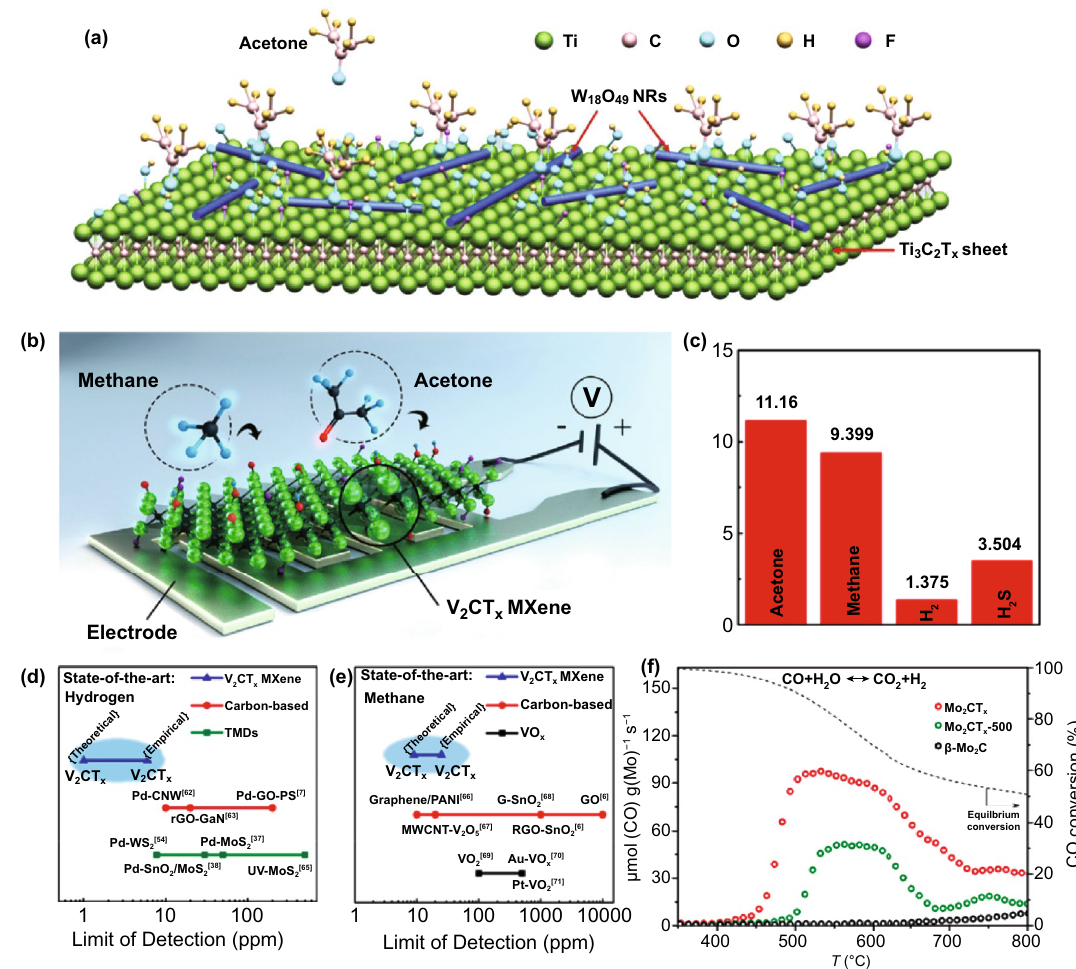
Fig. 10 Gas catalytic property of TMCs. a Schematic of the reaction between acetone and W 18 O 49 /Ti 3 C 2 T x composite. Reproduced with per- mission from Ref. [163]. Copyright 2020, Elsevier. b Schematic diagram of the sensing mechanism of the V 2 CT x gas sensor. c Theoretical LoD of V 2 CT x film toward acetone, methane, hydrogen and hydrogen sulfide at room temperature. Comparison of LoD of d hydrogen and e methane for room temperature gas sensor. Reproduced with permission from Ref. [161]. Copyright 2019, American Chemical Society. f WGS catalytic activity of Mo 2 CT x , Mo 2 CT x -500, and β-Mo 2 C. Reproduced with permission from Ref. [159]. Copyright 2019, American Chemical